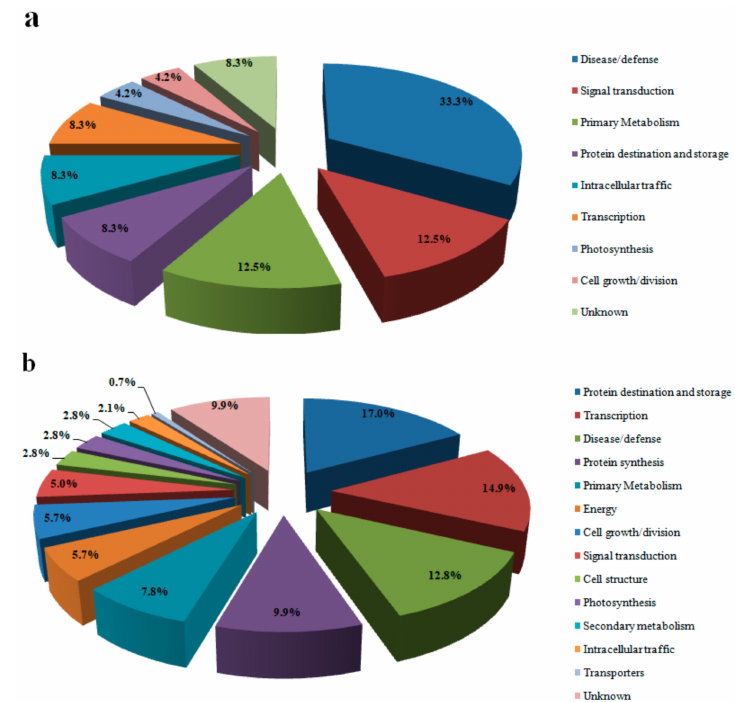
Figure 3. Functional classification of di ff erentially expressed proteins in hemp under Pb stress. ( a ) Proteins down-regulated in BM; ( b ) proteins down-regulated in